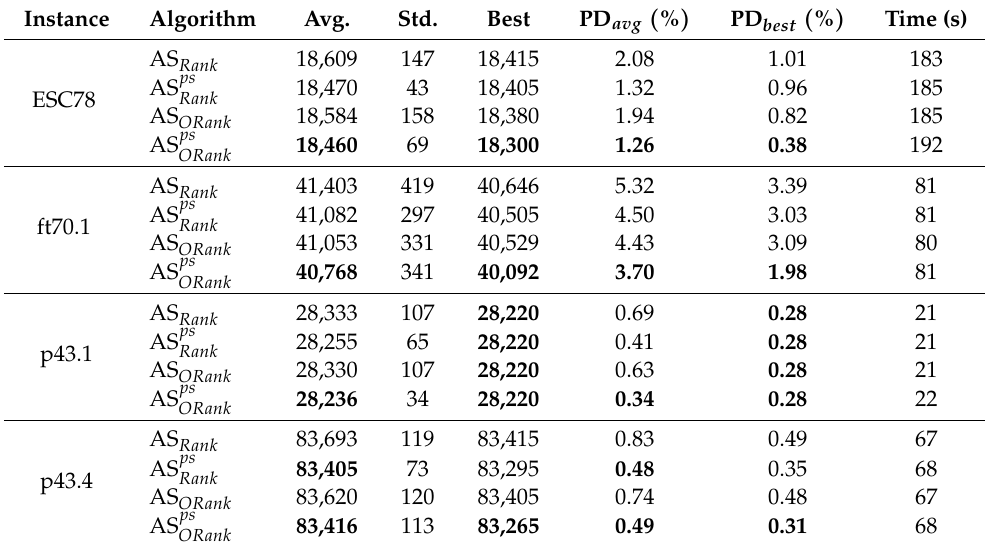
Table 4. Results for SOP instances obtained by Rank-based ACO variants. The best results for each problem instance are highlighted in